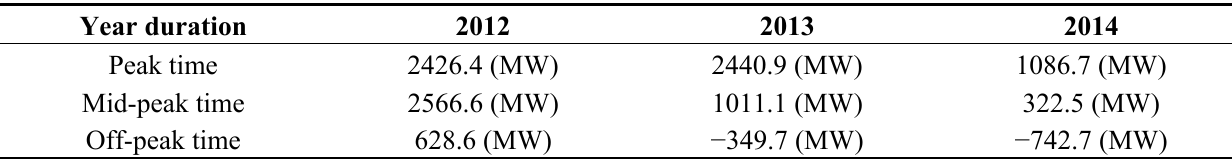
Table 4. The central to northern power flow capacity in the three periods during the winter from 2012 to 2014.